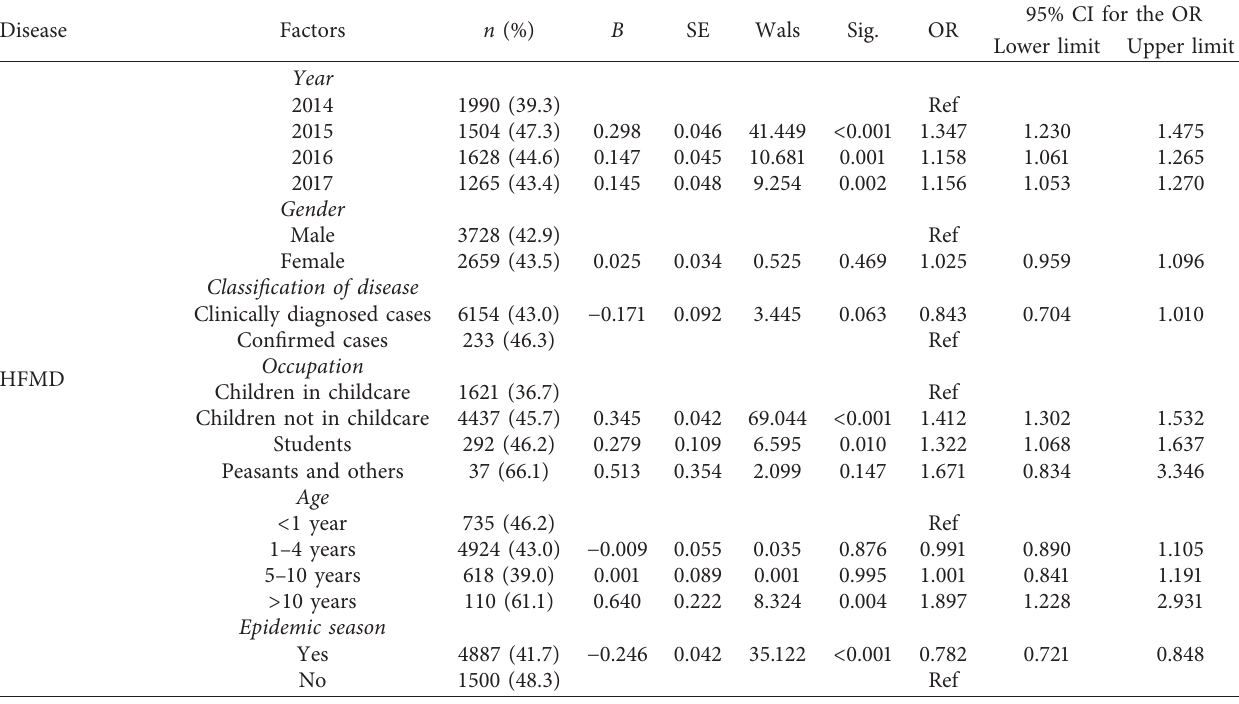
Table 4: Multivariable logistic regressions on associations of influencing factors with patients delayed in hospital visiting for hand-foot-and- mouth disease (HFMD) and epidemic parotitis.